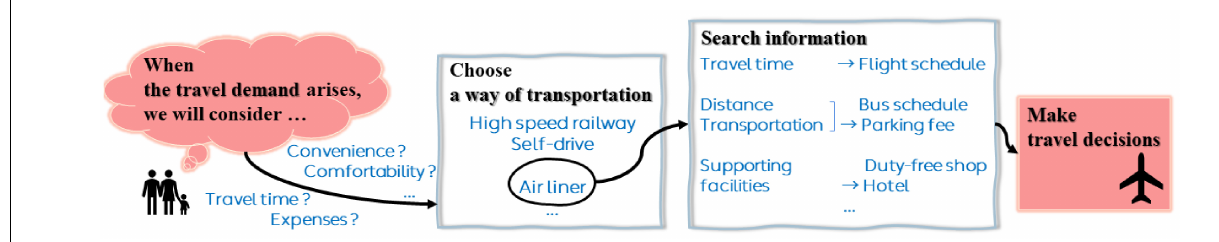
FIGURE 1 | Correlation mechanism between information search and travel decision-making.